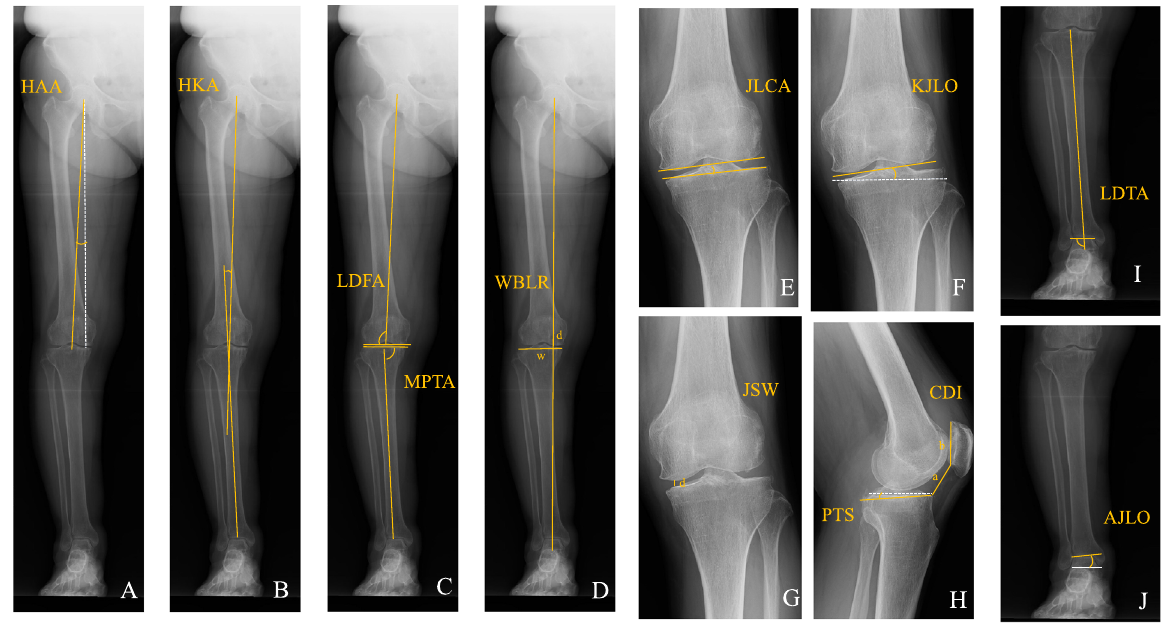
Figure 4. Radiological parameters. ( A ) hip abduction ankle (HAA), ( B ) hip knee ankle (HKA), ( C ) femorotibial angle (FTA), ( D ) lateral distal femoral angle (LDFA) and medial proximal tibial angle (MPTA), ( E ) weight-bearing line ratio (WBLR), ( F ) joint line convergence angle (JLCA), ( G ) knee joint line obliquity (KJLO), ( H ) joint space width (JSW), ( I ) posterior tibia slope (PTS) and Caton-Deschamps index (CDI), ( J ) lateral distal tibial angle (LDTA), ( K ) ankle joint line obliquity